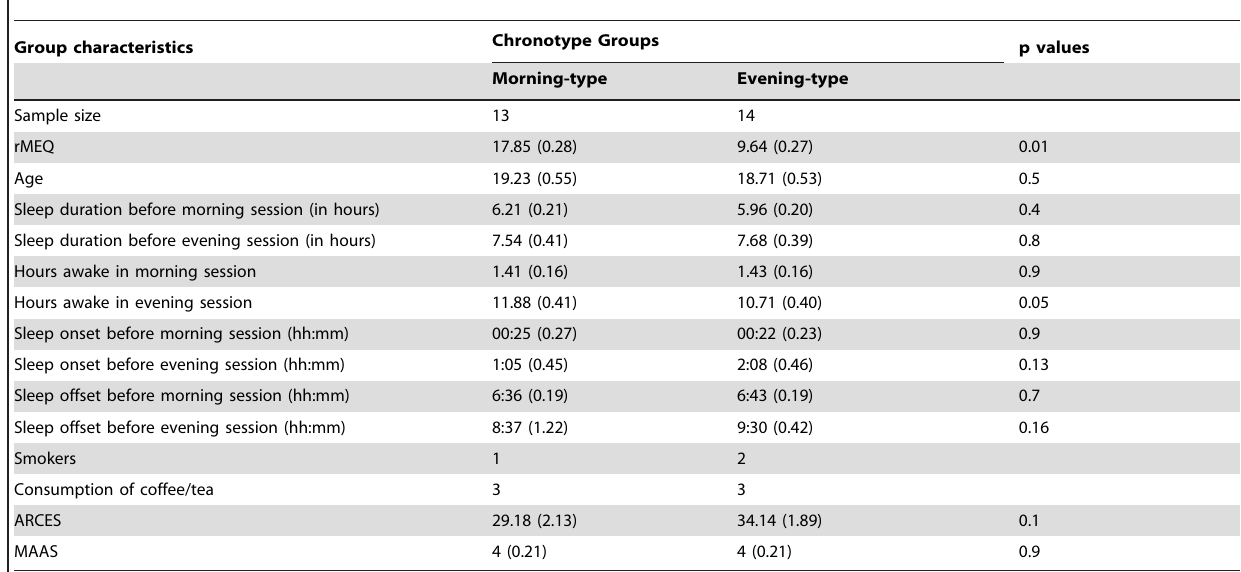
Table 1. Mean and standard deviation (between brackets) for demographic data according to chronotype group.